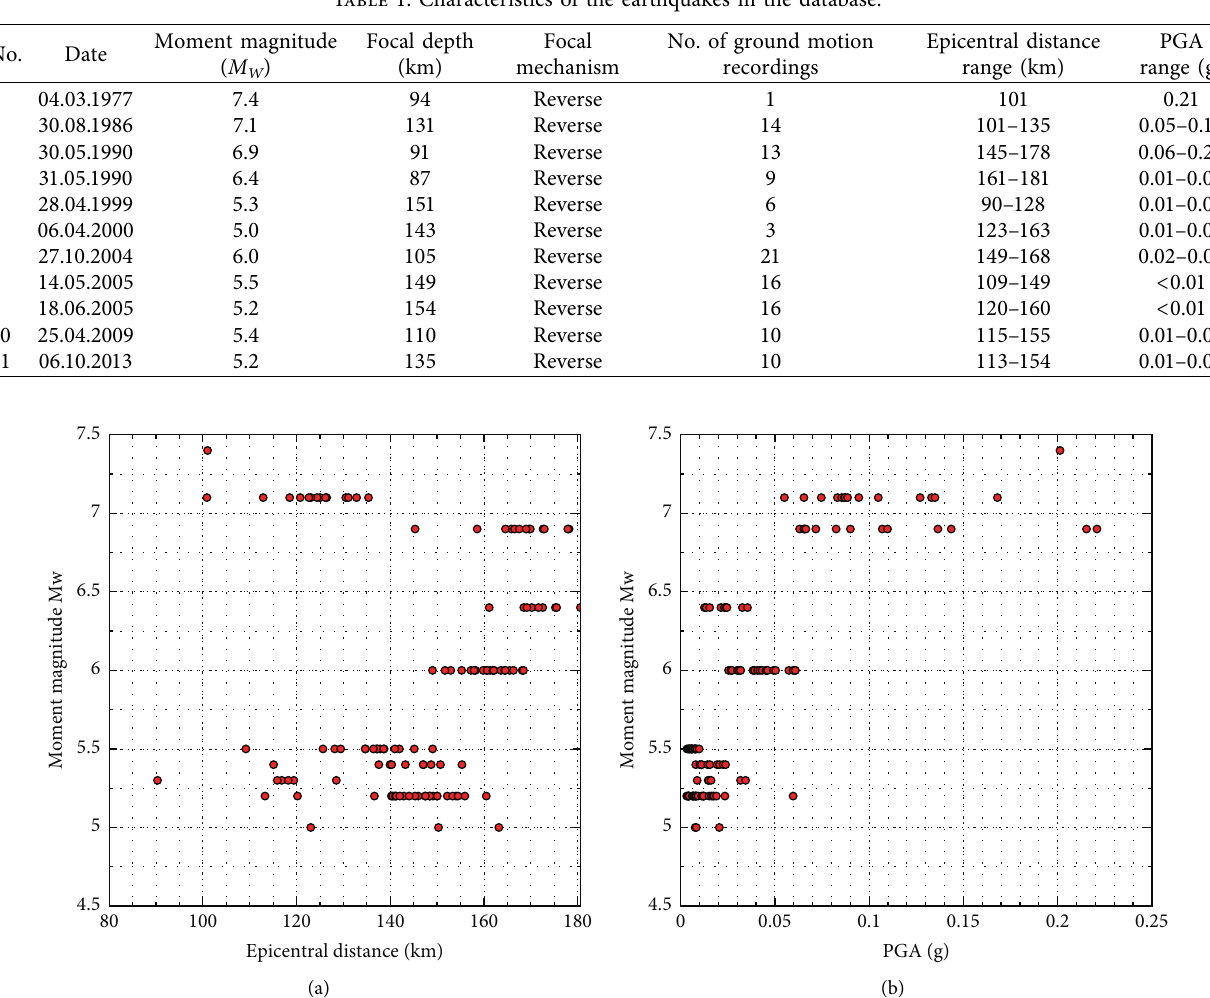
Table 1: Characteristics of the earthquakes in the database.